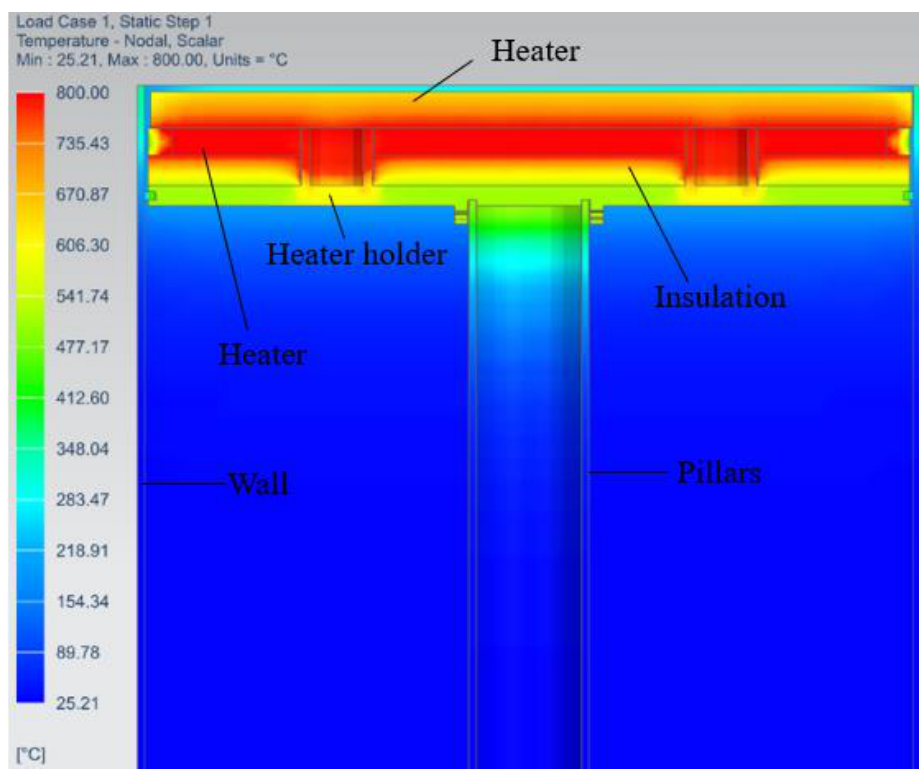
Figure 15. Thermal analysis results of the Concept 1 (QuickPre).